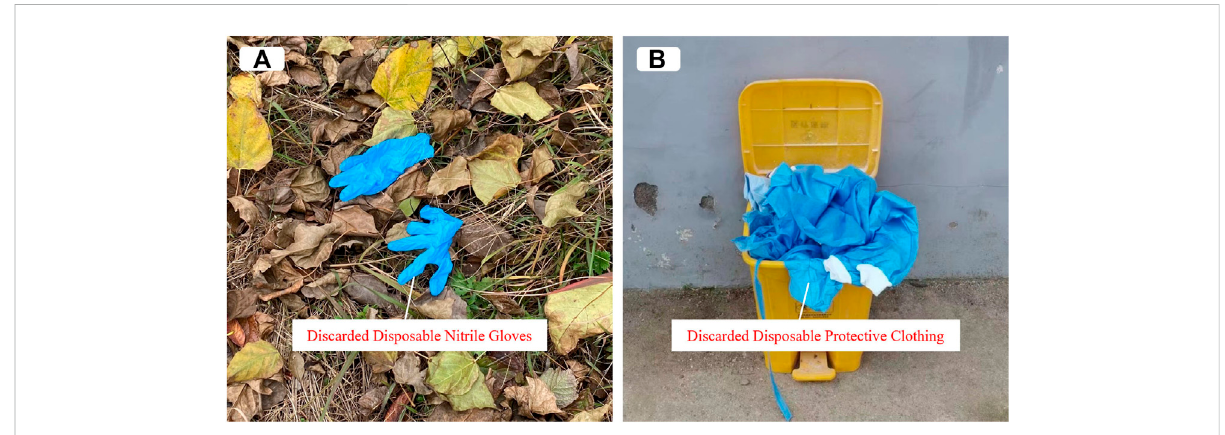
FIGURE 2 Pollution of COVID-19 PPE in YRFA. Pollution by (A) disposable nitrile gloves, (B) disposable protective clothing.